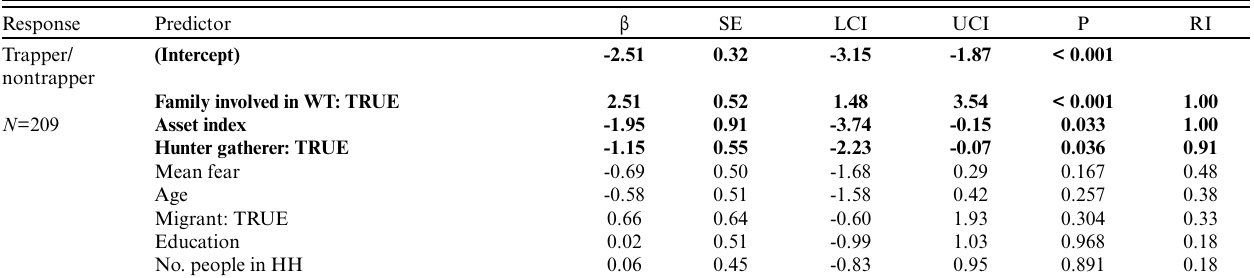
Table 2 . Summary of averaged generalized linear model (GLM) with binomial error to investigate predictors associated with live animal trapping households (HH) in systematically sampled villages, in the Moramanga district of Madagascar. Response Trapper/